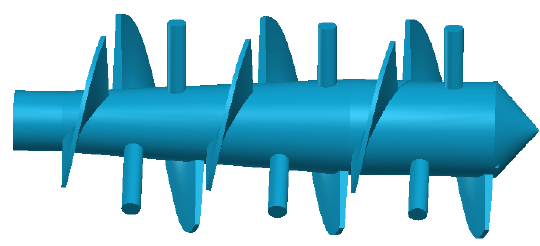
Figure 7. Improved stirring shaft.